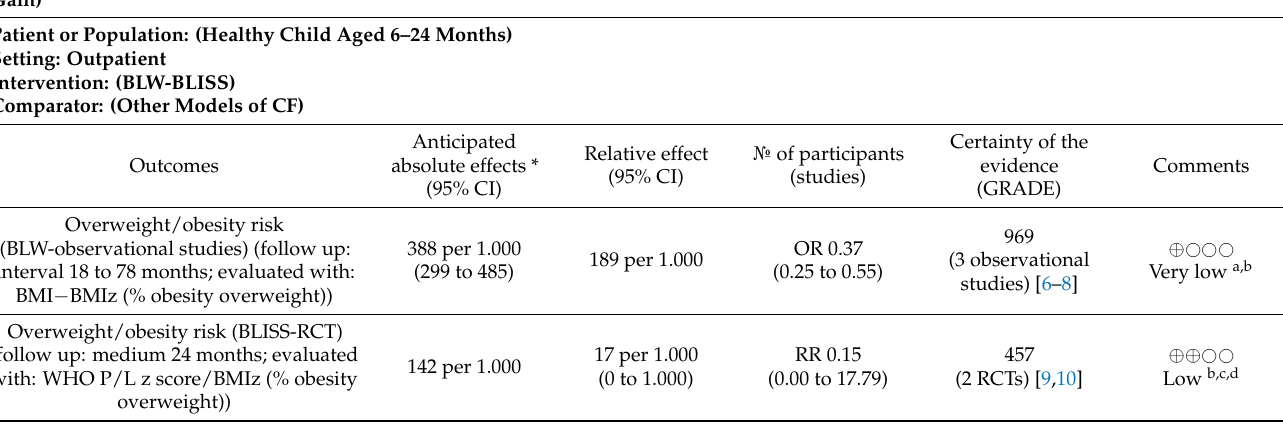
Table 2. BLW/BLISS and risk of overweight/obesity. Summary of findings for the main